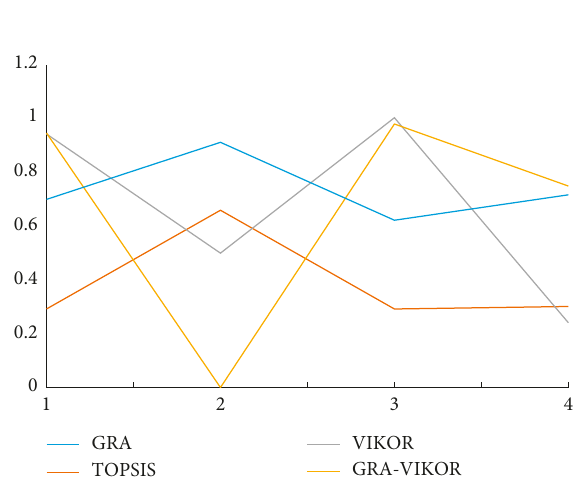
Figure 2: Comparative analysis of the results of different decision- making